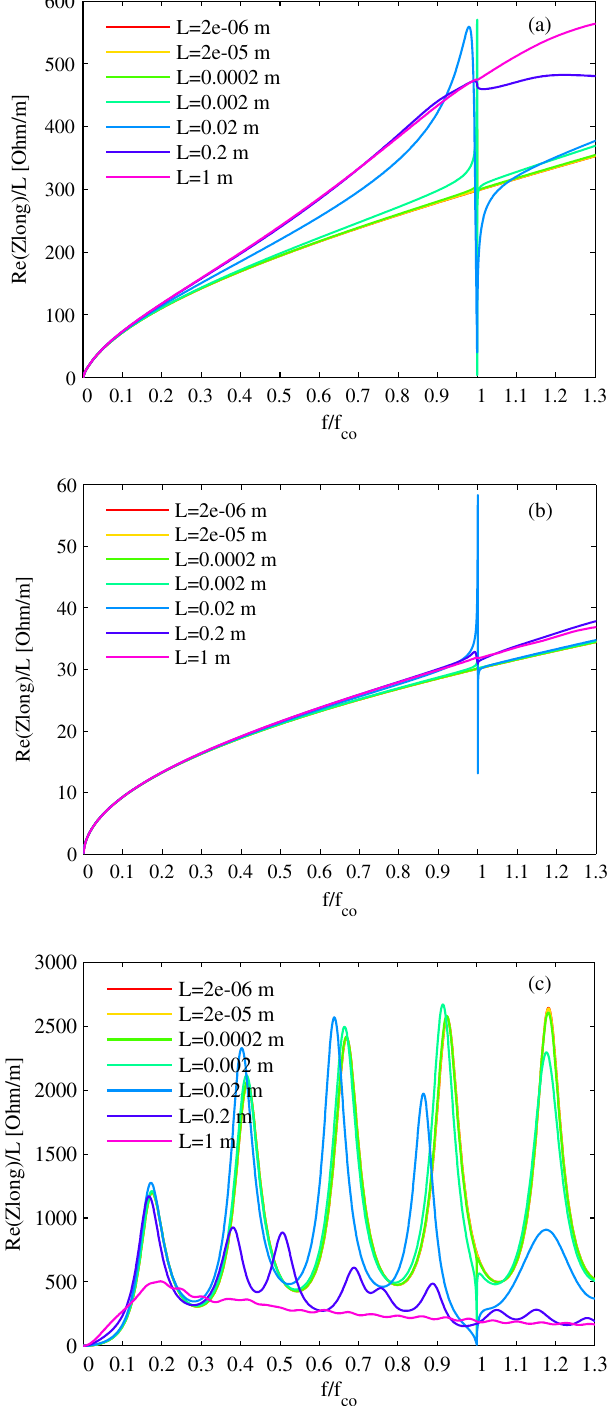
FIG. 11 (color online). (a)Impedancenormalizedoverthedevice length for conductivity σ ¼ 1 S = m. The length is varied from 20 um to 1 m. Mode matching parameters: S ¼ 10 , P ¼ 10 . (b) Impedance normalized over the device length for conductivity σ ¼ 100 S = m. The length is varied from 20 um to 1 m. Mode matching parameters: S ¼ 10 , P ¼ 10 . (c) Impedance normalized over the device length for conductivity σ ¼ 0 . 01 S = m. The length is varied from 20 um to 1 m. Mode matching parameters: S ¼ 10 , P ¼ 10 .